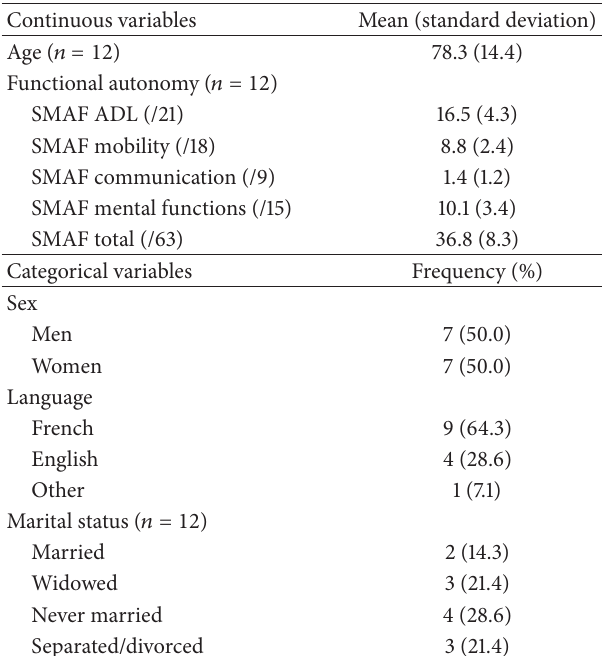
Table 1: Residents’ sociodemographic and clinical characteristics ( 𝑛 = 14 ).